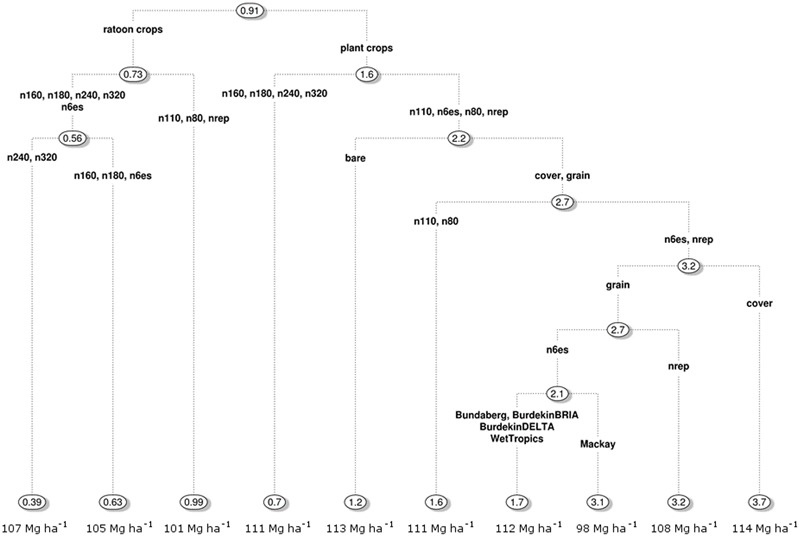
A pruned regression tree analysis of the factors determining nitrogen use efficiency [Mg cane (kg N)-1] predicted for 6.9 million sugarcane crops simulated under a wide range of management practices, soils and climates over 84 years. Labels are explained in Section “Management Factors That Influence NUE.” Average yields for the branches of the regression tree are displayed across the bottom of the figure.